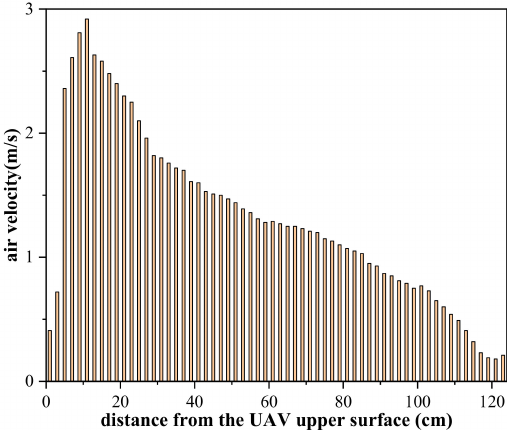
Figure 6. Air velocity of UAV center axis above the UAV upper